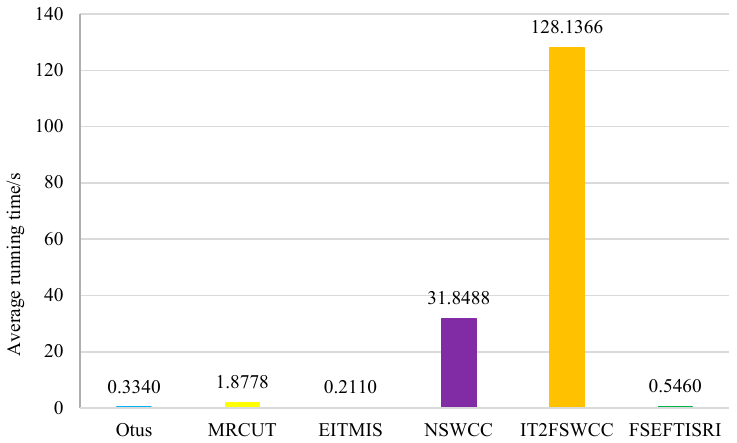
Figure 21. Comparison of the average running time of several algorithms.